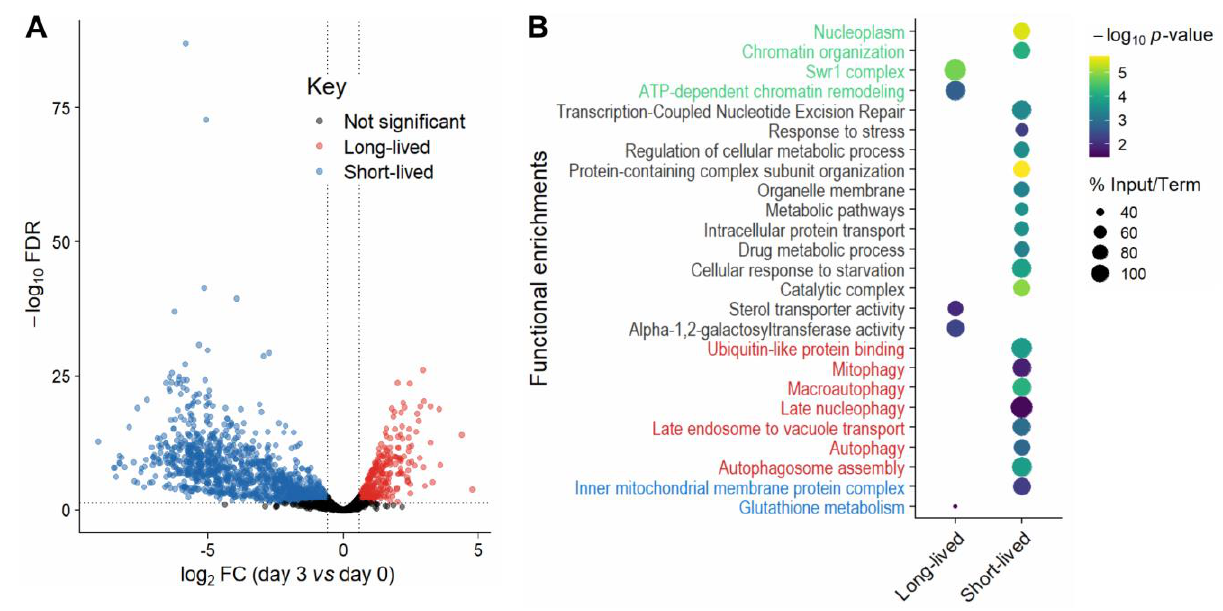
FIGURE 2: Long- and short-lived mutants and their functional enrichments. (A) Volcano plot of differences in mutant abundance on Day 3 relative to Day 0 (log 2 fold-change), based on Bar-seq of re-growth experiment, using edgeR analysis of three independent repeats [86]. Sig- nificance was determined using a fold-change (FC) cut-off of |log 2 (FC)| >log 2 (1.5) and a false discovery rate (FDR) cut-off of <0.05. (B) Select- ed functional enrichments from Metascape [87] are shown for long- and short-lived mutants, including chromatin-related terms (green), autophagy-related terms (red), mitochondrial-related terms (blue) and other terms (black). The colour scale indicates significance expressed as -log 10 p-values, and the size of the dots reflects the percentage of the input genes among all genes associated with the respective GO